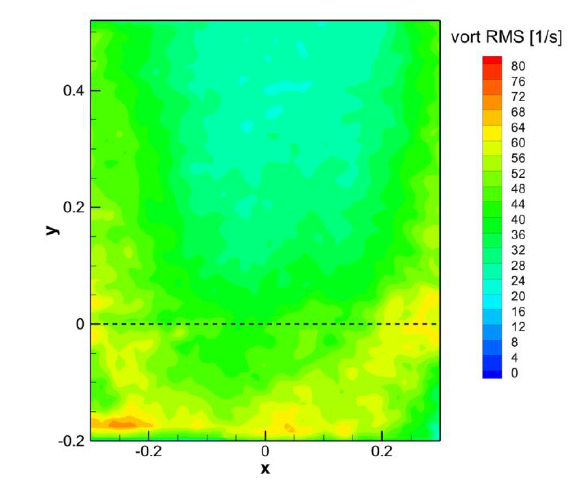
Fig. 8. RMS vorticity distribution. Re =